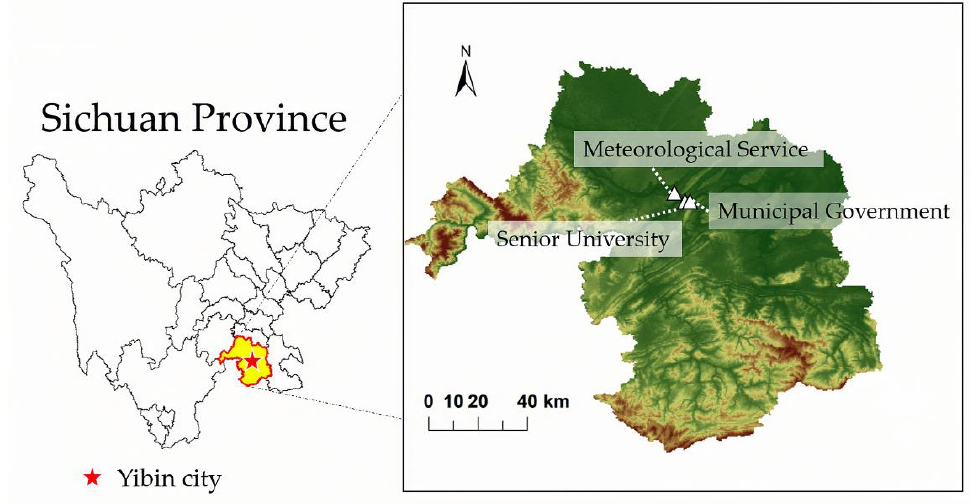
Figure 1. Map of Sichuan Province and location of monitoring sites in Yibin city.